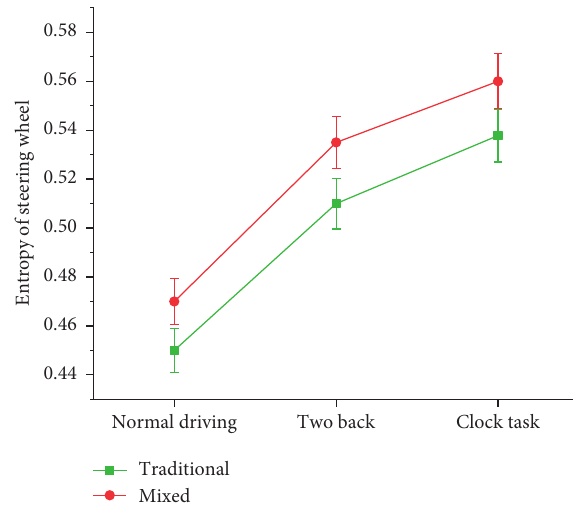
Figure 18: Interaction effect of the driving tasks and environment on the SE. Table 3: Subjective evaluation